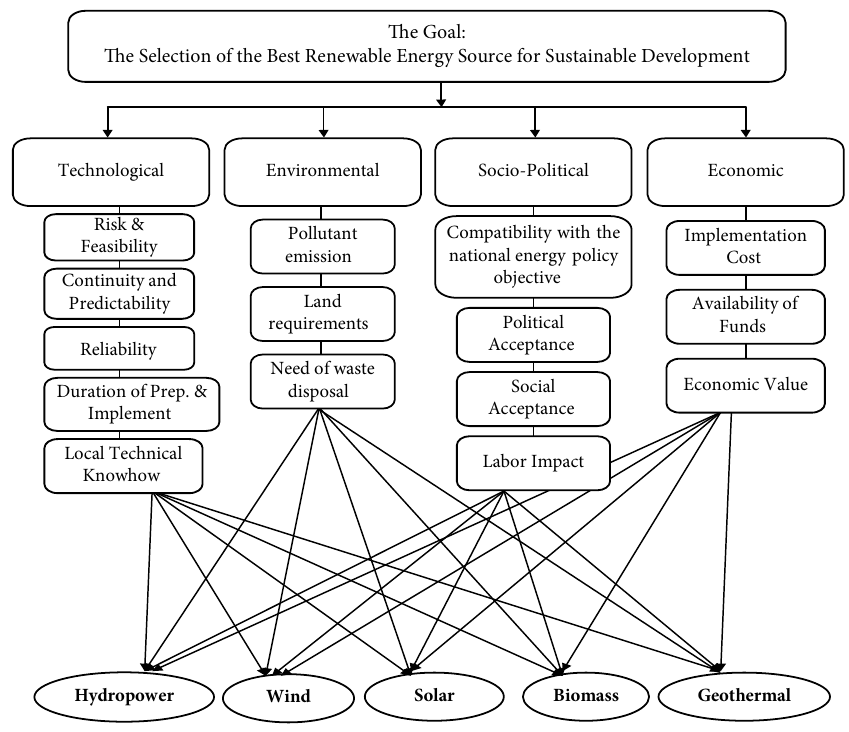
Fig. 2. hierarchy of the problem